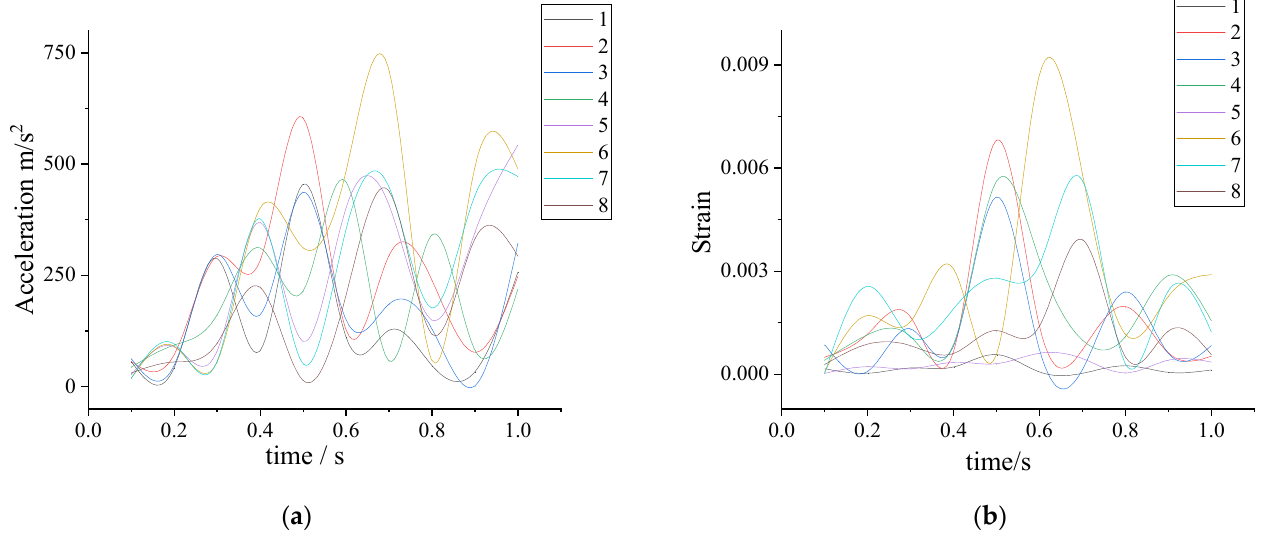
Figure 13. Transient analysis results of each detection point. ( a ) is the transient analysis of acceleration response; ( b ) is the transient analysis of strain response.